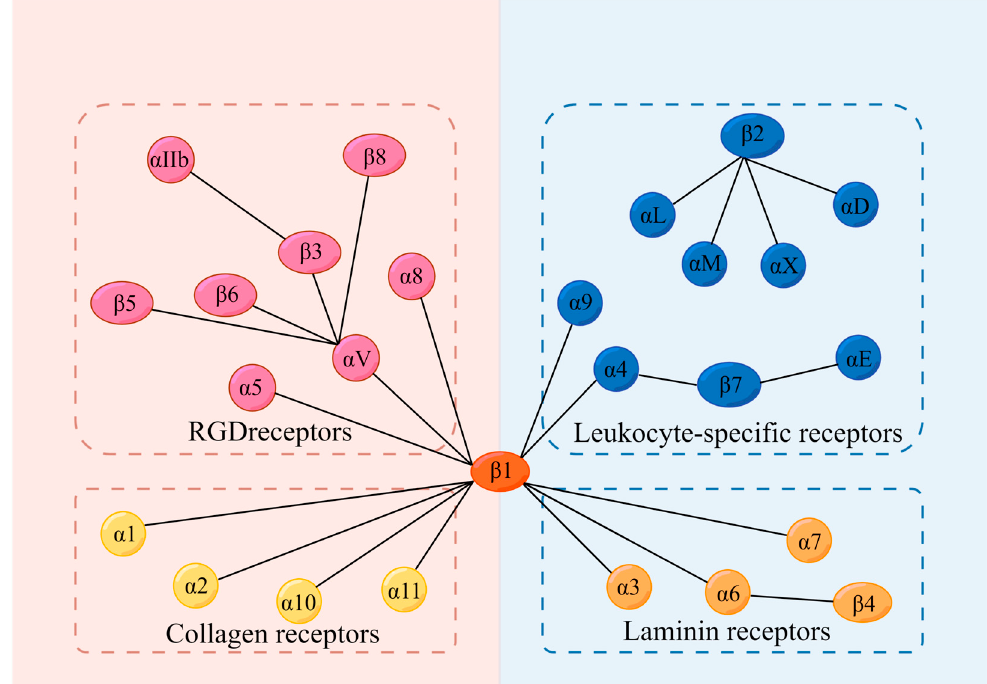
Figure 1. Integrins and their 4 categories of ligands; 18 α subunits and 8 β subunits constitute 24 integrins in humans, which can be divided into 4 categories according to their receptors. They are RGD receptors, leucocyte-specific receptors, collagen receptors, and laminin receptors. RGD: Arg- Gly-Asp.